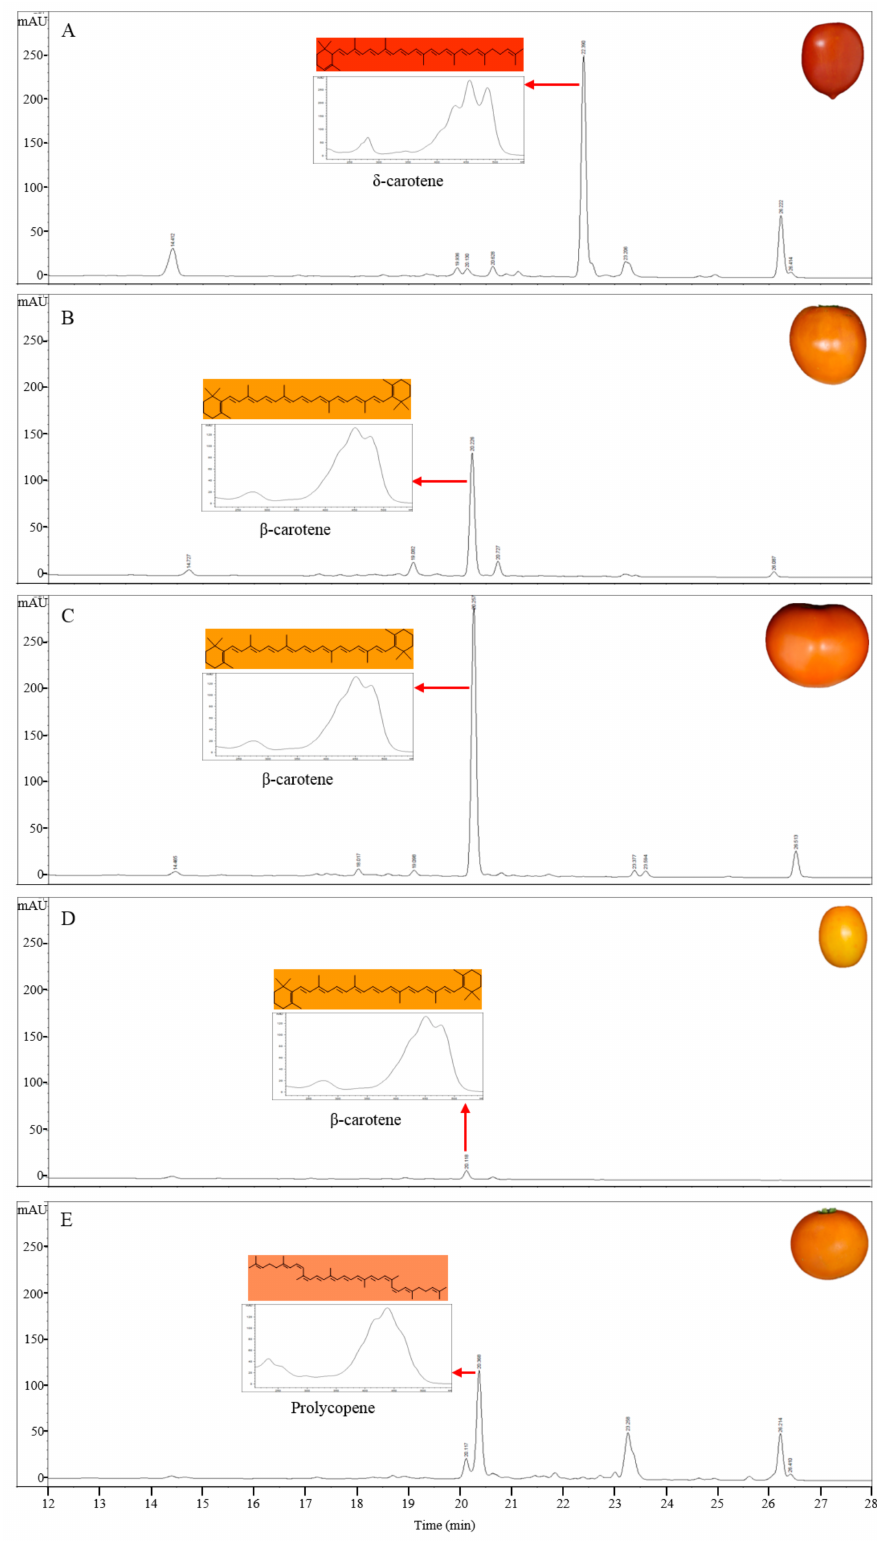
Figure 2. HPLC profiles of carotenoids in tomato germplasms as determined by their absorption at 450 nm. ( A ) LA4099; ( B ) LA3311; ( C ) LA4255; ( D ) Sugar Yellow; ( E ) LA3533. Eight other lines (LA0030, LA0351, LA3002, LA3128, LA3183, LA3682, Cispene, and Gold Minichal) accumulating prolycopene showed similar HPLC